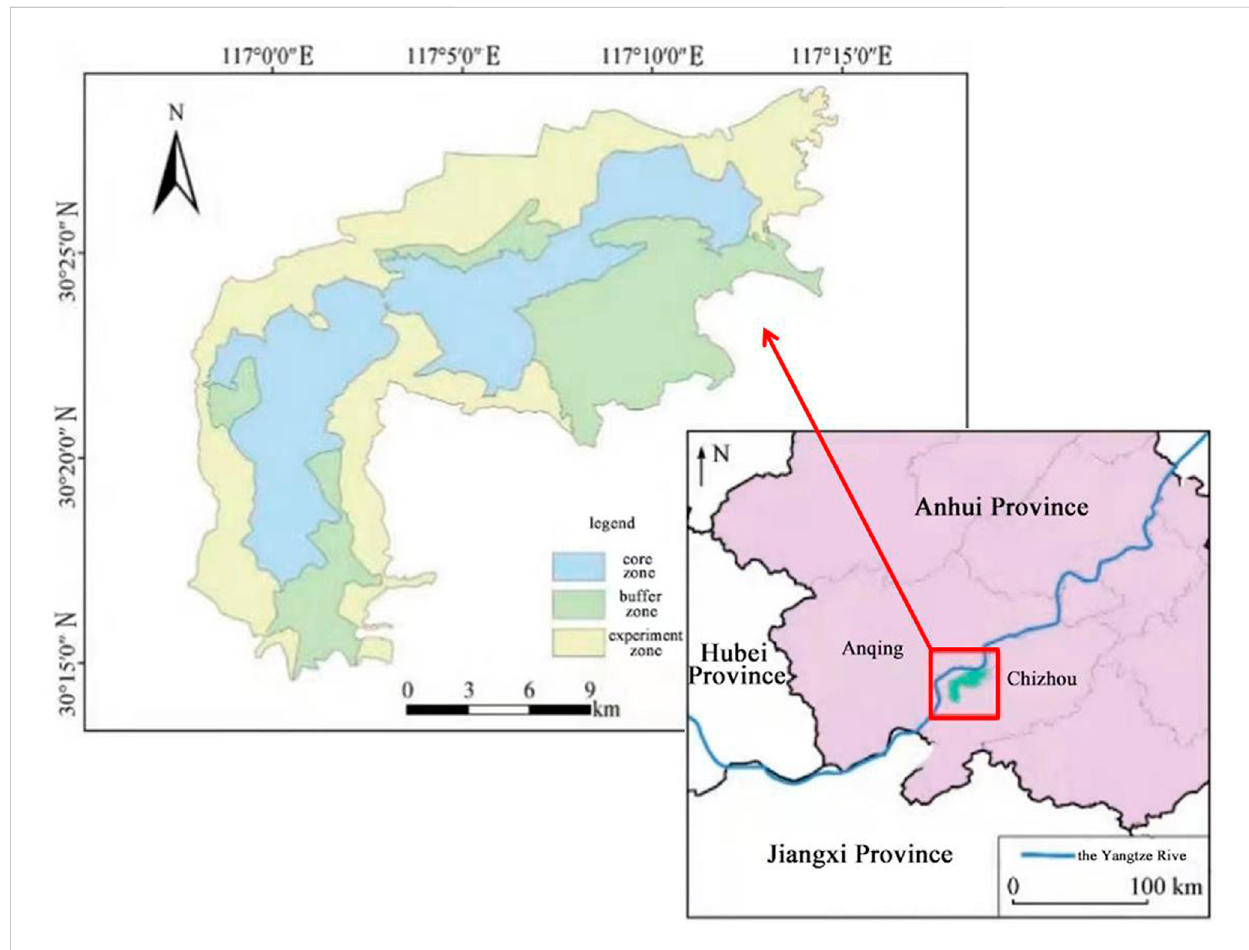
FIGURE 1 Location and function zones distribution of study